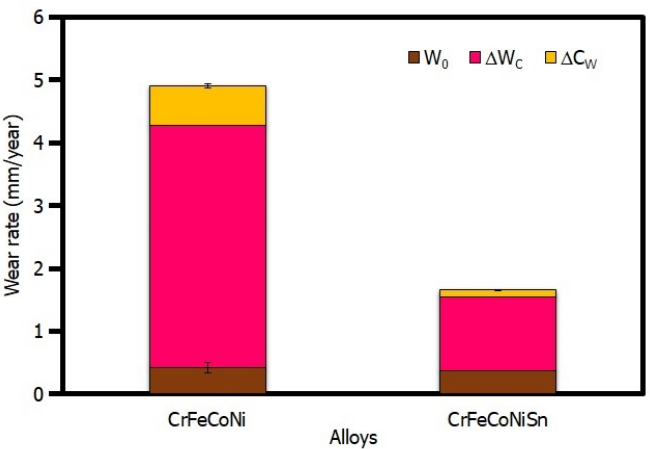
Figure 11. Tribocorrosion testing parameters for CrFeCoNi and CrFeCoNiSn tested in 0.6 M NaCl solution at ambient temperature.